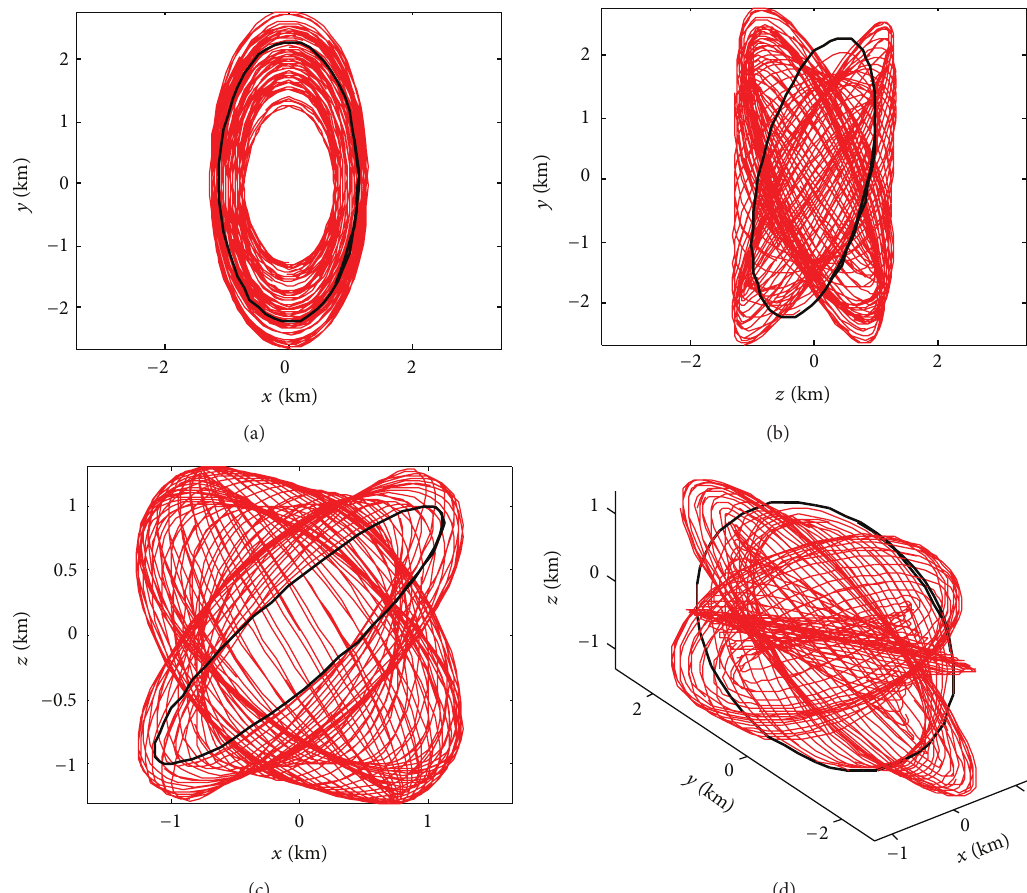
Figure 11: Quasiperiodic relative trajectories generated by the optimal gain of 0.31 during 30 days: presented is the relative orbit during the first orbital period in every day; the black thicker line indicates the initial formation